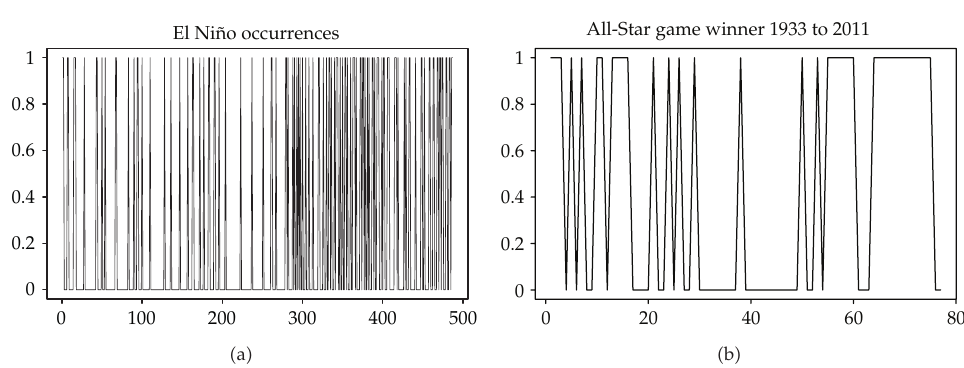
Figure 1: El Ni˜no and All-Star data. Note clear shifts in the probability that each series takes on the value